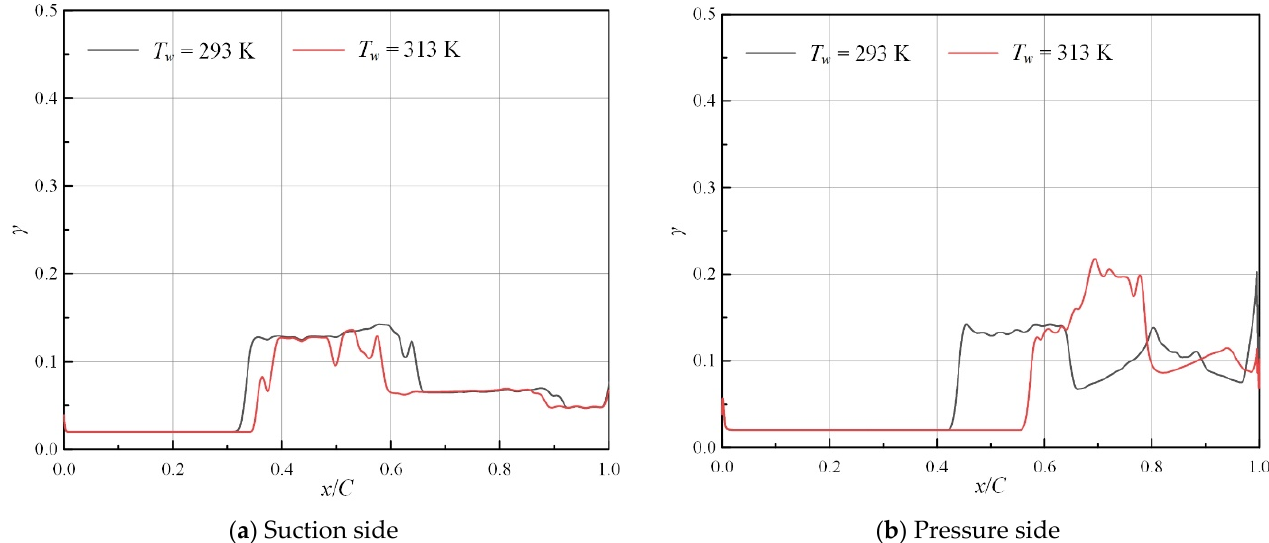
Figure 13. Distribution of intermittency along streamwise direction under various surface tempera ‐ tures ( ε = 0.5%, α = 0°, Ma = 0.75).